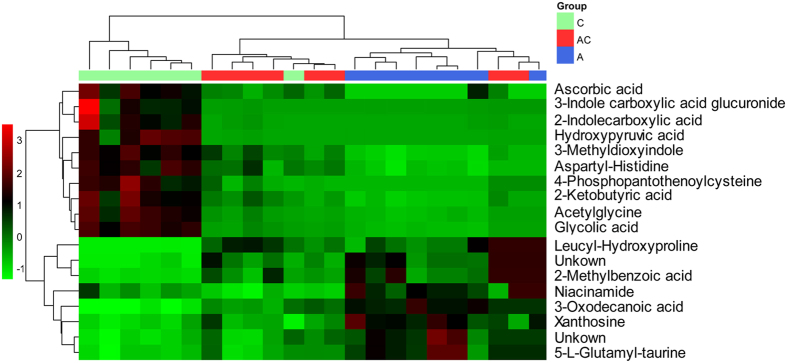
Significant changes in urinary metabolites are expressed as a heatmap showing metabolite changes in all treatment groups, detected by UPLC-Q-TOF/MS.(C) Control group, (A) antibiotic group, (AC) CSGS + antibiotic group.